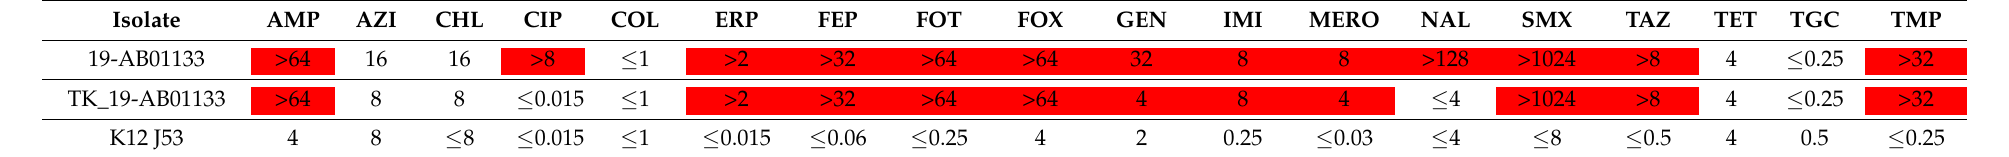
Table 1. Minimal inhibitory concentrations (MIC) of following antimicrobial agents (mg/L) to 19-AB01133 and its transkonjugant TK_19AB01133. MIC values classified as non-wildtype are colored in red. Ampicillin (AMP); Azithromycin (AZI); Cefepime (FEP); Chloramphenicol (CHL); Ciprofloxacin (CIP); Colistin (COL); Ertapenem (ERP); Cefotaxime (FOT); Cefoxitin (FOX); Gentamicin (GEN); Imipenem (IMI); Kanamycin (KAN); Meropenem (MERO); Nalidixic acid (NAL); Sulfamethoxazole (SMX); Ceftazidime (TAZ); Tetracycline (TET); Tigecycline (TGC); Trimethophrim